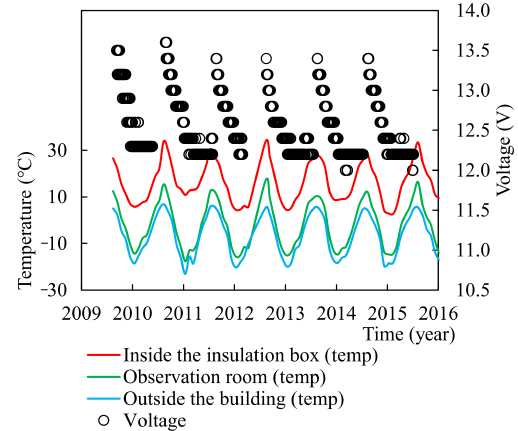
Figure 5. Daily averages of ambient temperatures outside the build- ing, within the observation room, and inside the insulation box, along with daily voltage readings for the batteries. Temperatures in- side the insulation box and observation room were measured by the CO 2 measurement system at the same time that atmospheric CO 2 concentrations were measured. The temperature outside the build- ing was measured by JMA; data were taken from the JMA web- site (http://www.data.jma.go.jp/obd/stats/etrn/index.php). One hun- dred batteries (12V) were connected in parallel, and the voltage was checked when the measurement